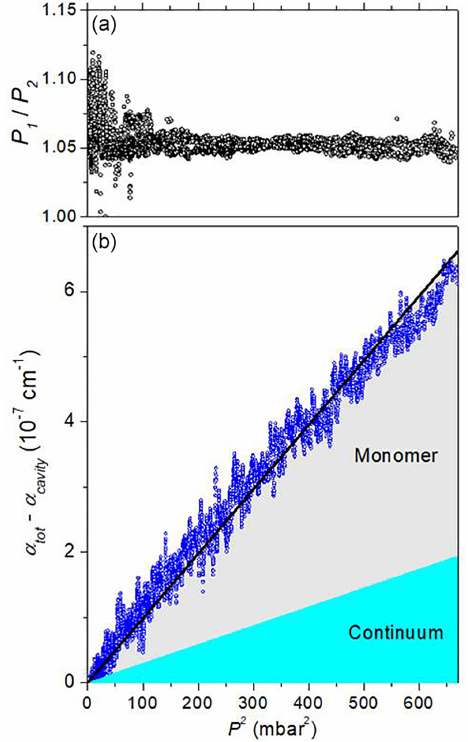
Figure 2. (a) Ratio of the pressure values deduced from the H 16 lines at 3006.975cm − 1 ( P 1 ) and at 3007.127cm − 1 ( P 2 ) as a func- tion of P 1 for a pressure ramp at 50 ◦ C. (b) Corresponding variation of the water continuum absorption near 3007cm − 1 as a function of pressure squared. The plotted data correspond to the superposition of 5 distinct pressure ramps smoothed over 10 adjacent measure- ments points. The solid black line corresponds to the best linear fit. The constant term due to the cavity losses obtained from the fit was subtracted. The simulated contribution of water monomer wings and that of the self-continuum are highlighted (in grey and cyan,